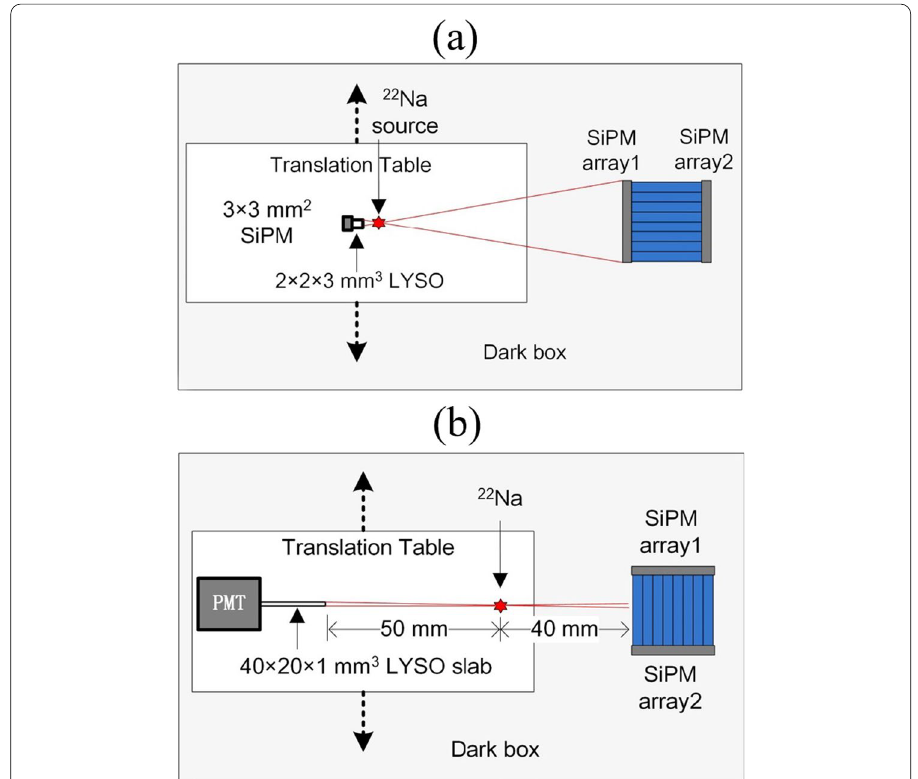
Fig. 4 a Experimental setup for the flood histogram, energy resolution, and timing resolution measurements, the reference detector consisting of a